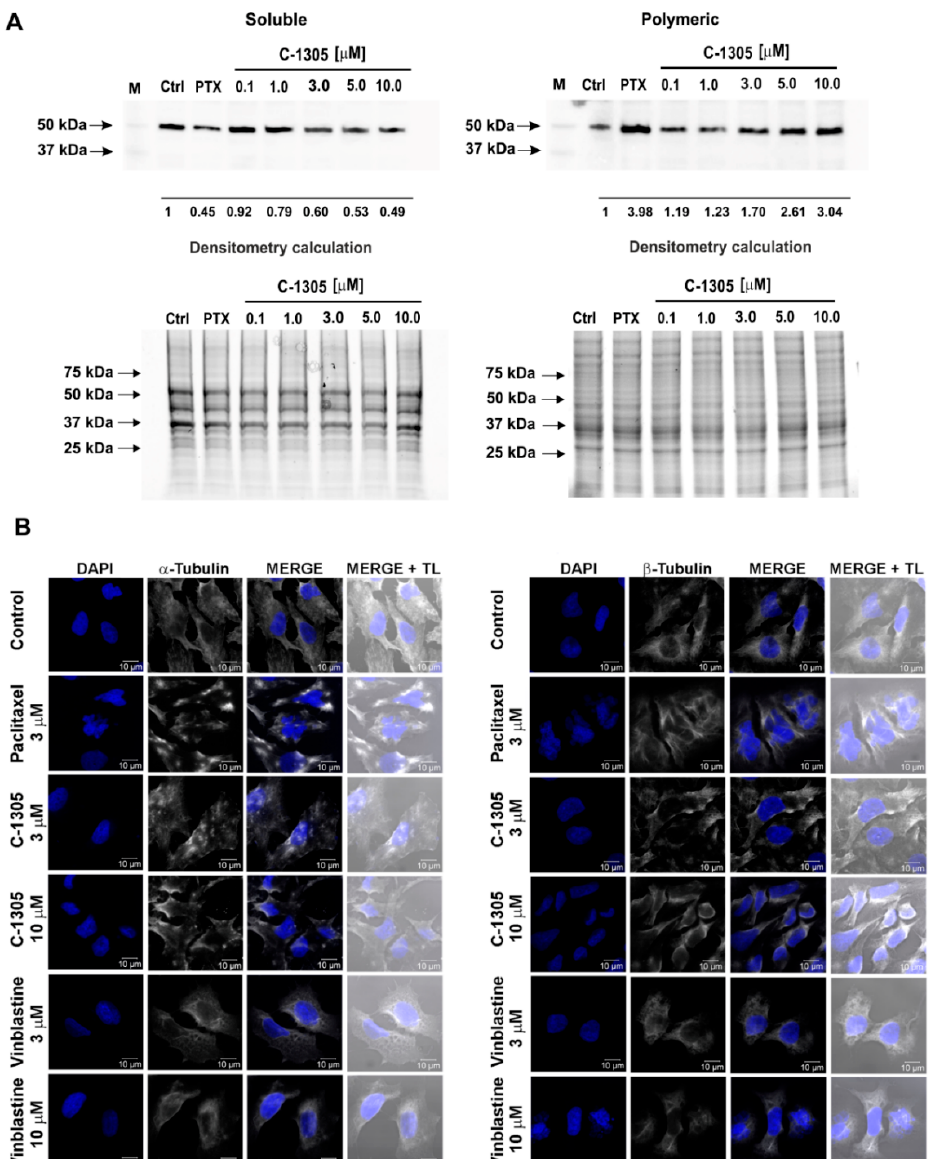
Figure 7. C-1305 stabilizes polymeric tubulin and changes the microtubule network in A549 cells. ( A ) SDS-PAGE (bottom panel) and Western blot analysis (top panel) of soluble and polymeric tubulin fractions in A549 cells after C-1305 treatment. Western blot analysis of soluble (S) and polymeric (P) tubulin fractions using rabbit primary antibody against β -tubulin (ab18207, Abcam) and HRP-conjugated secondary antibodies (Bio-Rad) and detected using ECL (Amresco). The molecular weight markers are indicated by the arrows on the left (Precision Plus Protein ™ Kaleidoscope ™ Prestained Protein Standards BioRad, #1610375). Densitometry was performed using Image Lab software v. 4.1 (Bio-Rad) and Gel-Pro Analyzer v. 4.0 (Media Cybernetics L.P); the amount in each band was calculated in relation to the corresponding band of the control lane. The bottom panel total protein loading controls SDS-PAGE of soluble (S) and polymeric (P) tubulin fraction isolated from A549 cells after 24h of treatment. The results of the soluble and polymeric tubulin fractions in A549 cells treated with C-1305 for 6 h are shown in Figure S9. Raw Western blot files are shown in Figure S12. ( B ) The C-1305 effects on the microtubule network were observed by immunofluorescence using a Confocal Scanning Laser Microscope (LSM) and Transmitted Light (TL). A549 cells were incubated in the absence and the presence of C-1305 (3 or 10 µM), paclitaxel (3 µM) and vinblastine (3 or 10 µM) for 24 h. Cells were fixed and processed for immunostaining with antibodies against α -tubulin (left panel) and β -tubulin (right panel) for 2 h, then reacted with Alexa fluoro-conjugated secondary antibody. The scale bar is 10 µm. Paclitaxel and vinblastine were used as the reference compound.